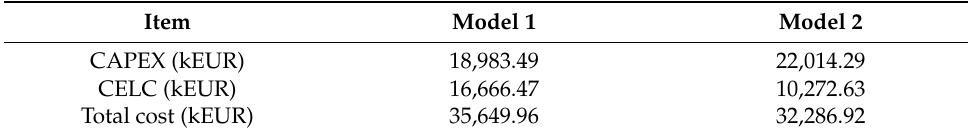
Figure 11. Ten trails for layout optimization of Model 1 and Model 2 obtained by V-APSO-LS. Table 1. Simulation results of Model 1 and Model 2.